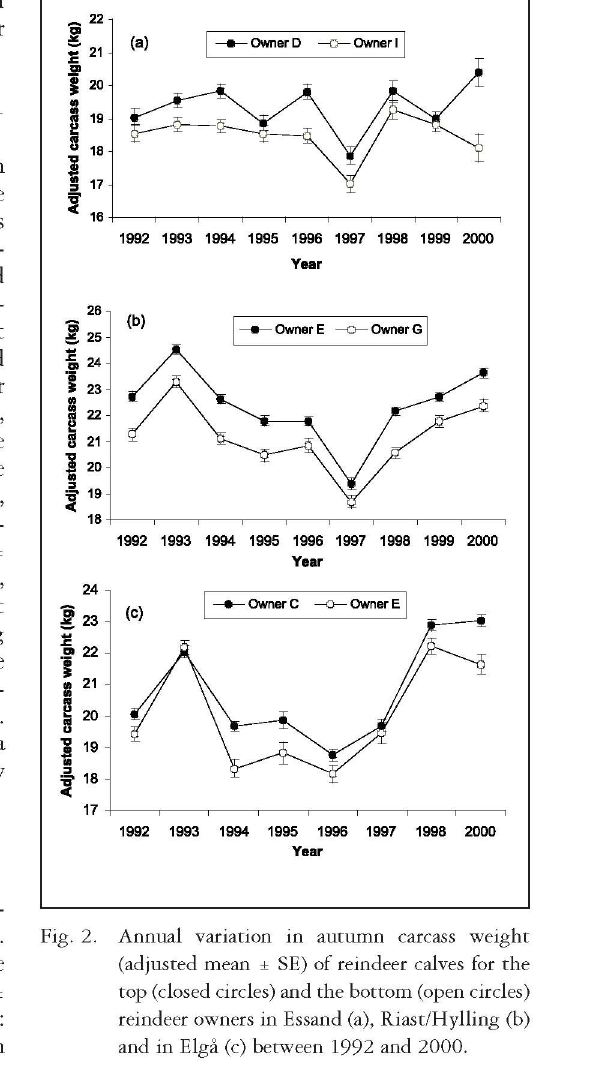
Fig. 2. Annual variation in autumn carcass weight (adjusted mean ± SE) of reindeer calves for the top (closed circles) and the bottom (open circles) reindeer owners in Essand (a), Riast/Hylling (b) and in Elgå (c) between 1992 and